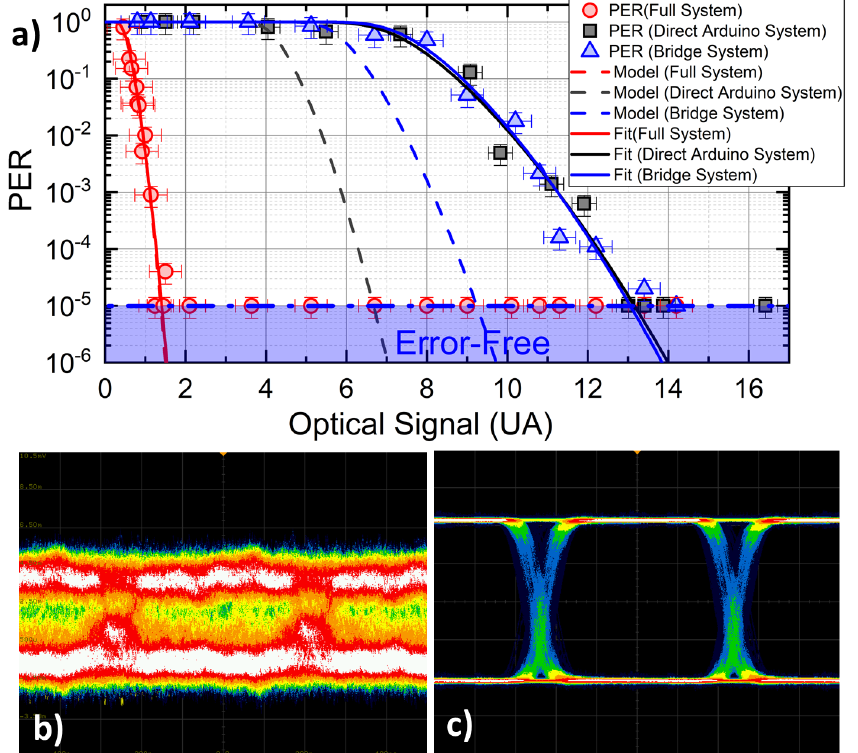
Figure 3. ( a ) PER as a function of the optical signal (OS): comparison between the three experimental systems used. ( b ) Eye diagrams related to OS = 5 AU case of the panel recorded for direct PD output and ( c ) after SDR output ( full system